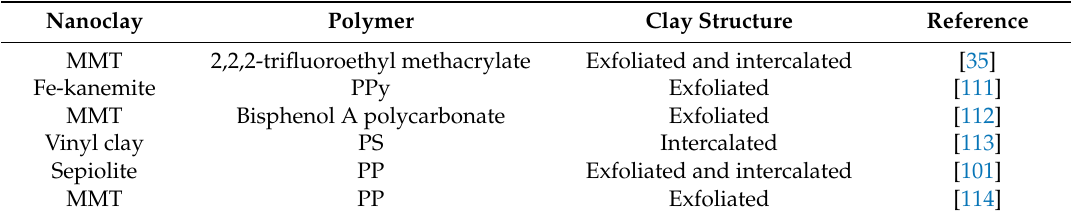
Table 4. Polymer/nanoclay prepared by the melt-blending method and dispersion states. PPy: polypyrrole; PP: